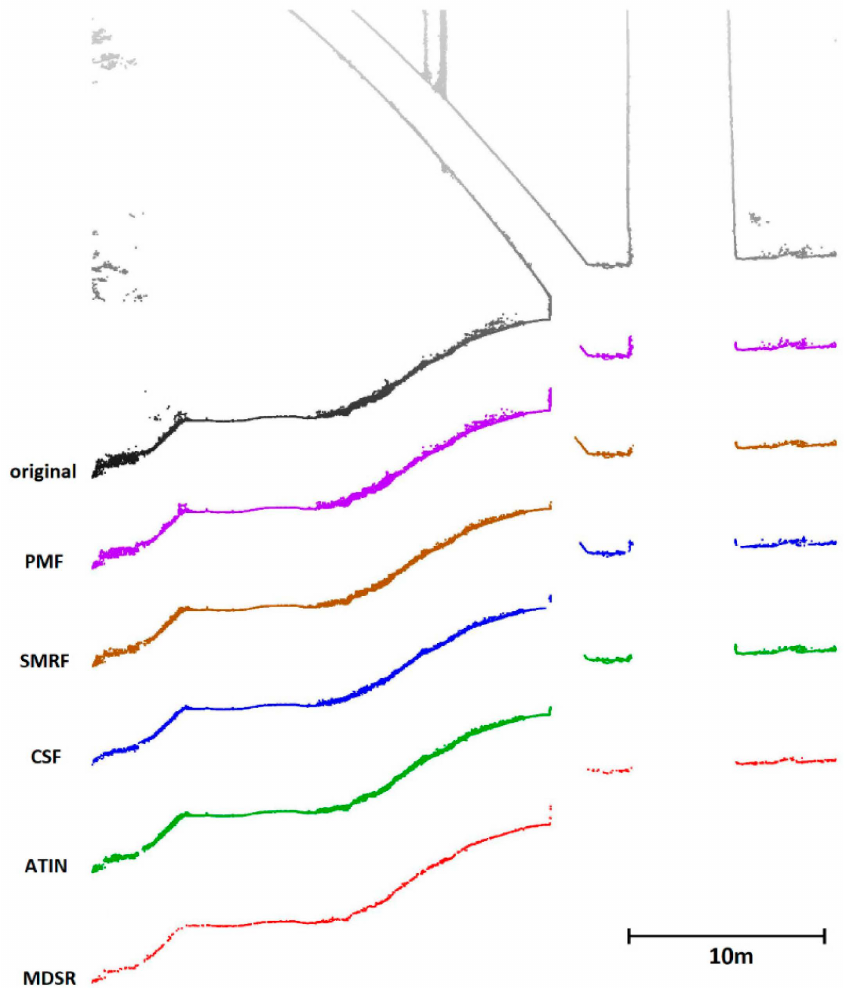
Figure 12. Profiles from site 4 filtering (upper part of the cloud describing the bridge, which plays no role in this evaluation, is cropped): gray—original cloud; purple—PMF; brown—SMRF; blue—CSF; green—ATIN;